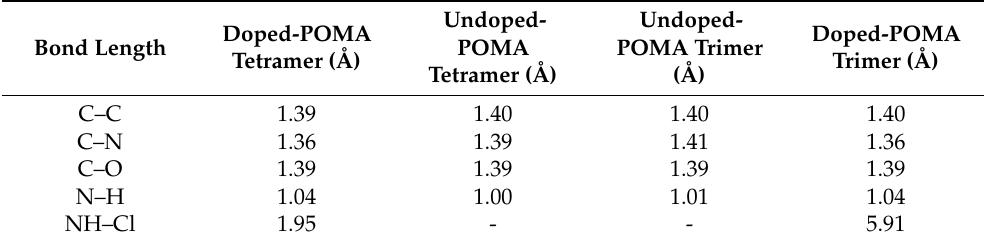
Table 2. Bond length of doped-POMA (ES-POMA) tetramer, undoped-POMA tetramer, doped- POMA (ES-POMA) trimer, and undoped-POMA trimer.